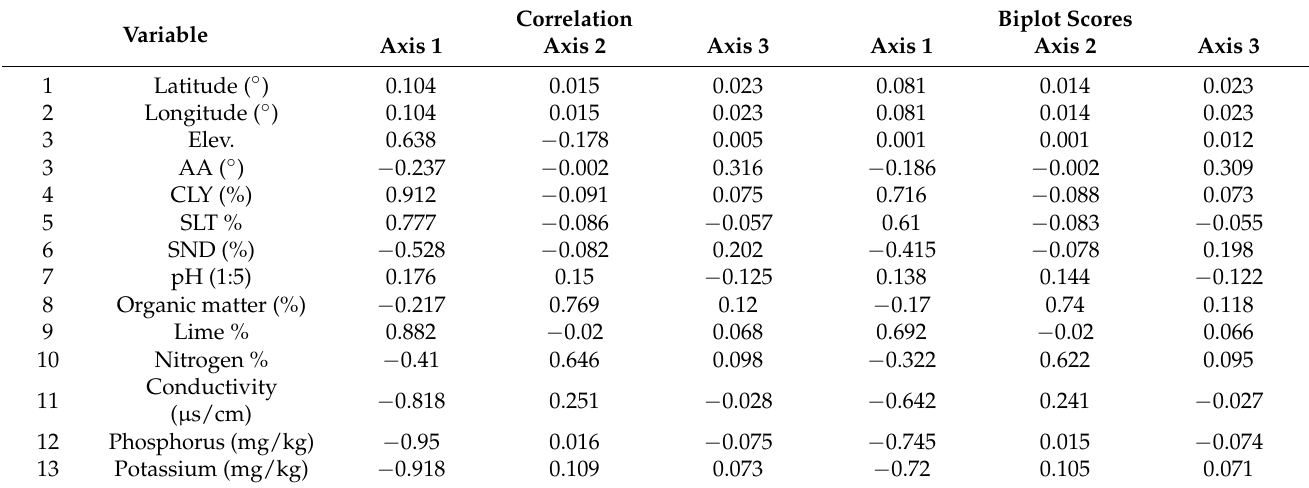
Table 5. Correlation and biplot scores of the environmental and soil variables operating on the Silybum marianum